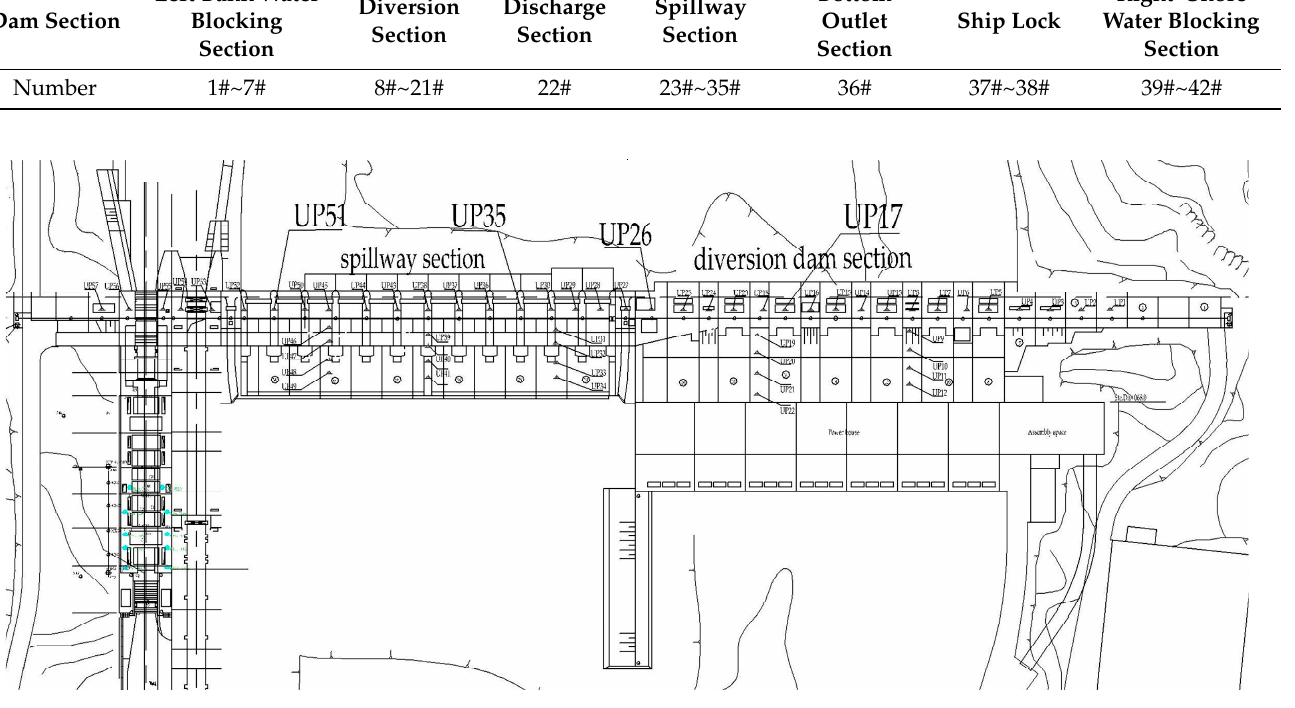
Figure 5. The arrangement of uplift pressure measurement points.